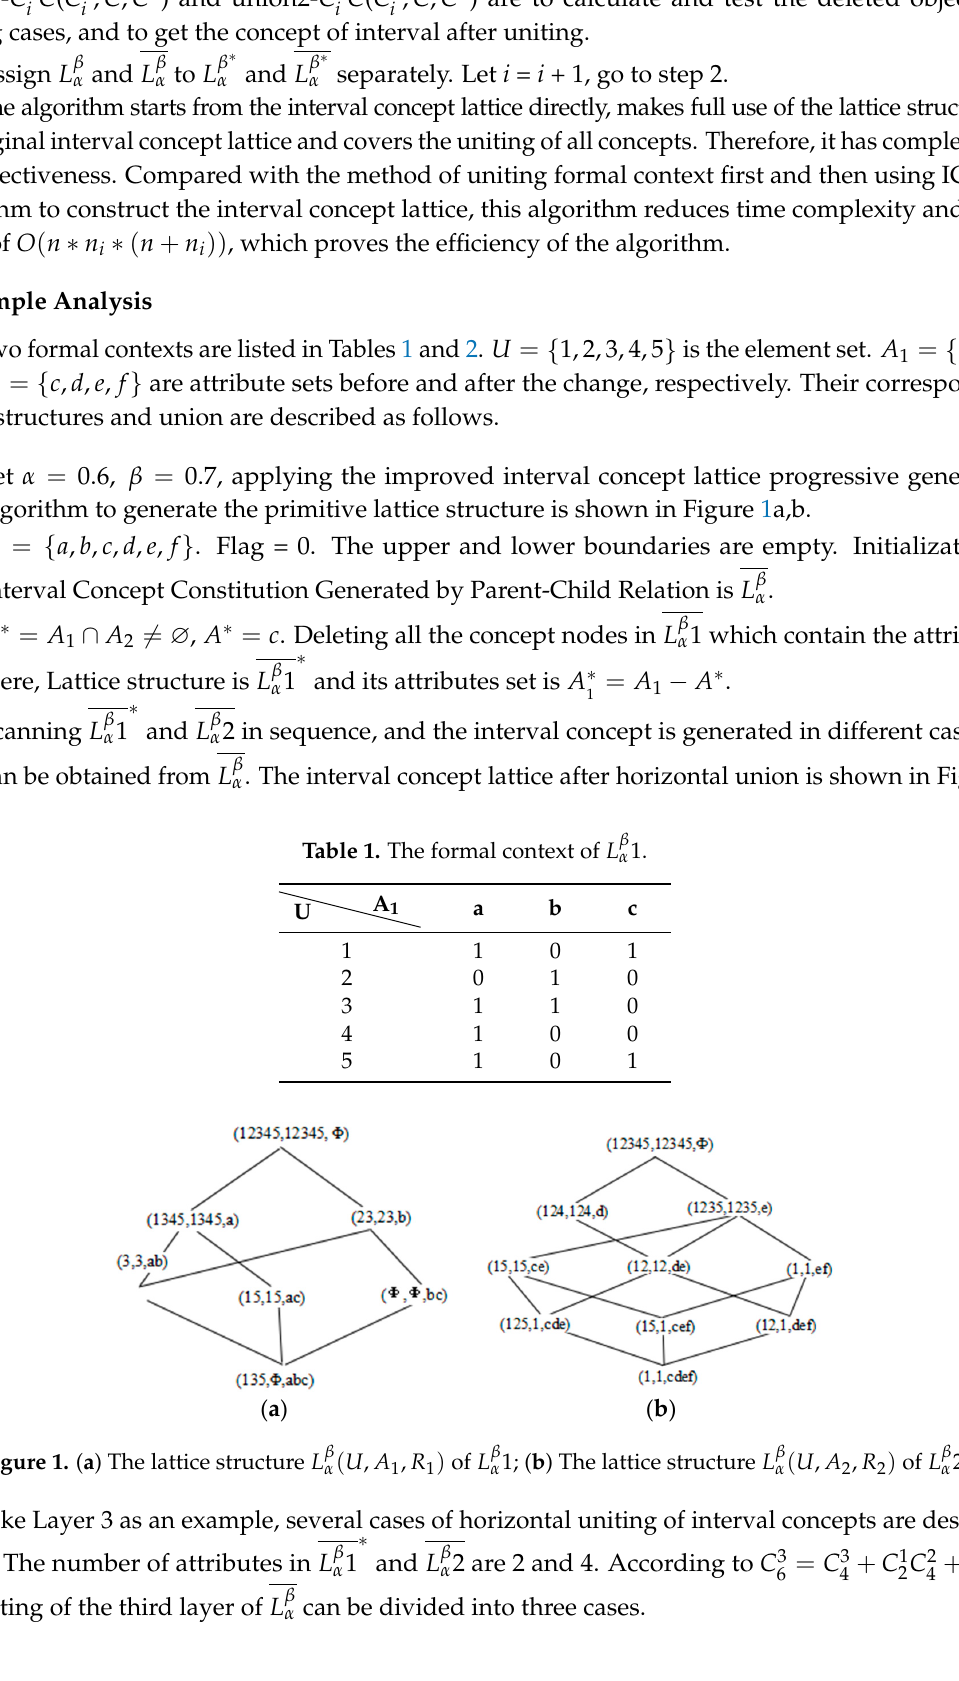
Figure 1. ( a ) The lattice structure ),,(